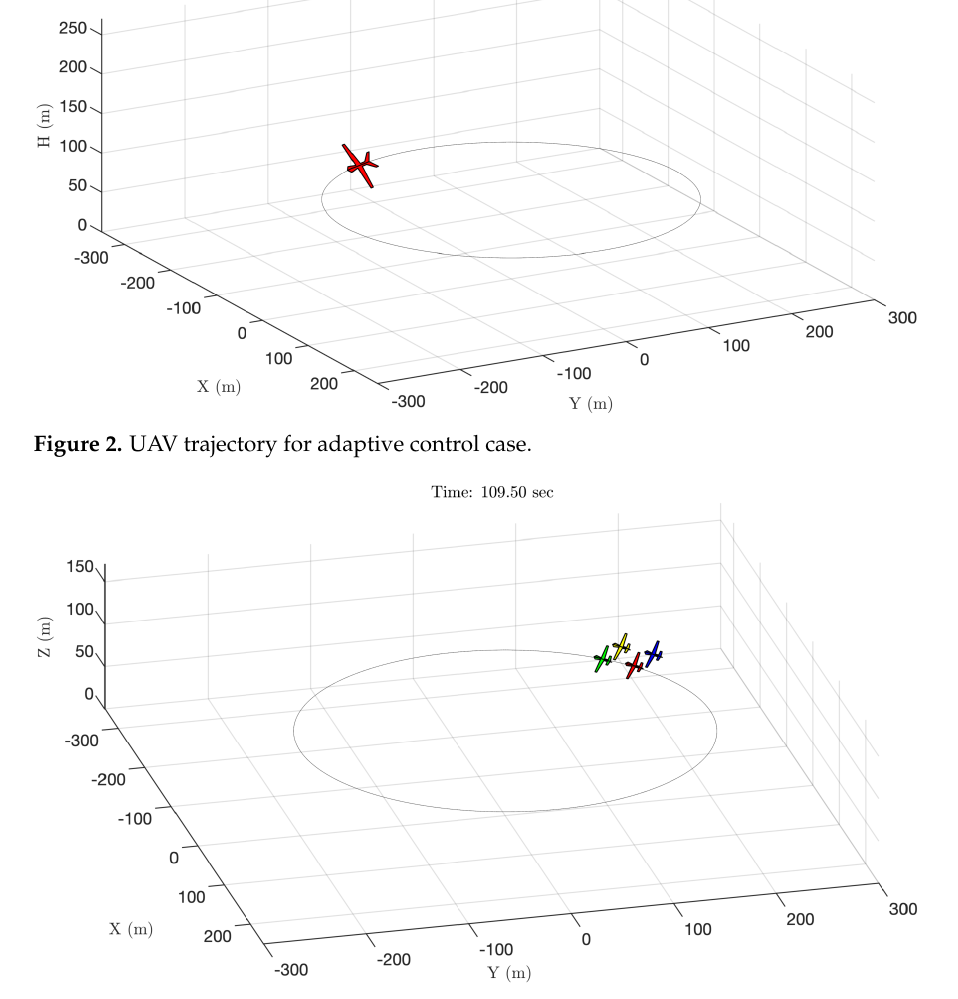
Figure 3. UAV trajectory for group control